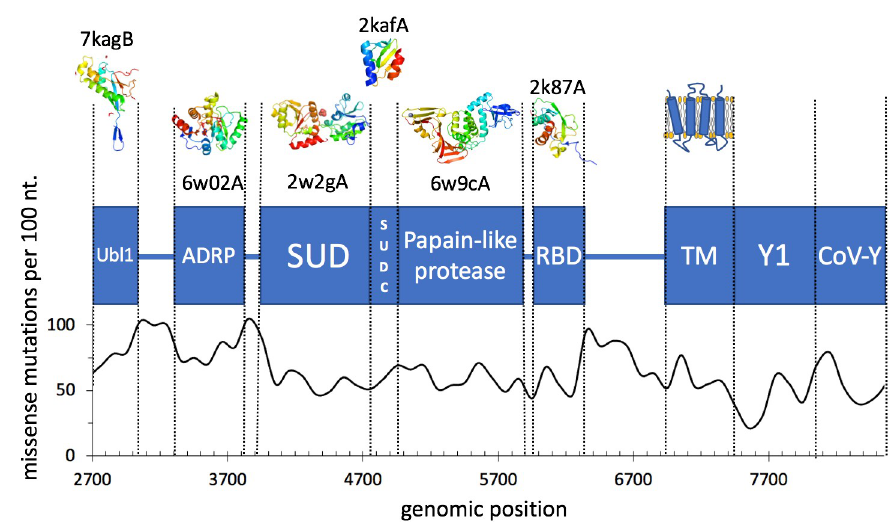
Fig 2. Domains and missense mutation rate per 100 nt window in the nsp3